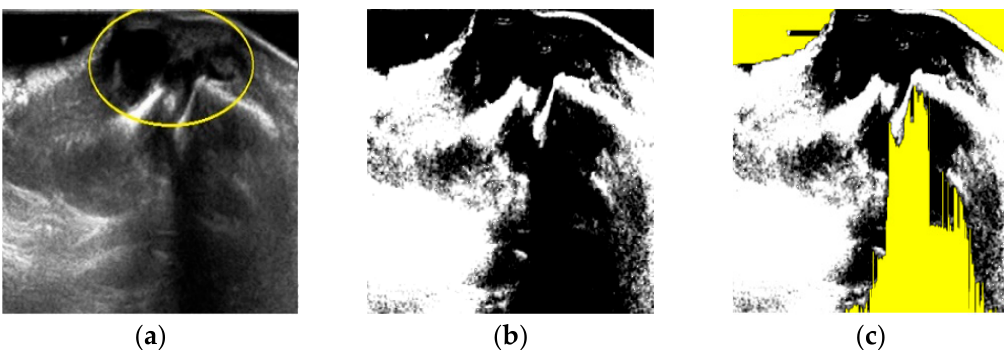
Figure 2. The effect of fuzzy stretching and noise reduction. ( a ) Input image, ( b ) after stretching, ( c ) noise reduction (yellow).